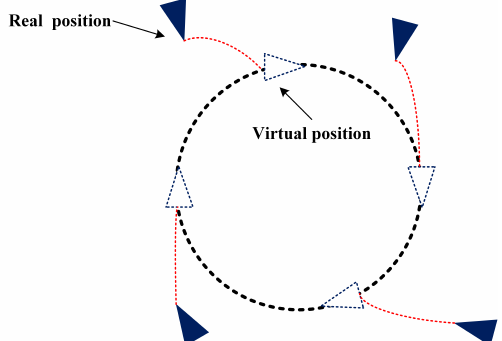
Figure 6. An illustration of virtual-structure-based circular formation